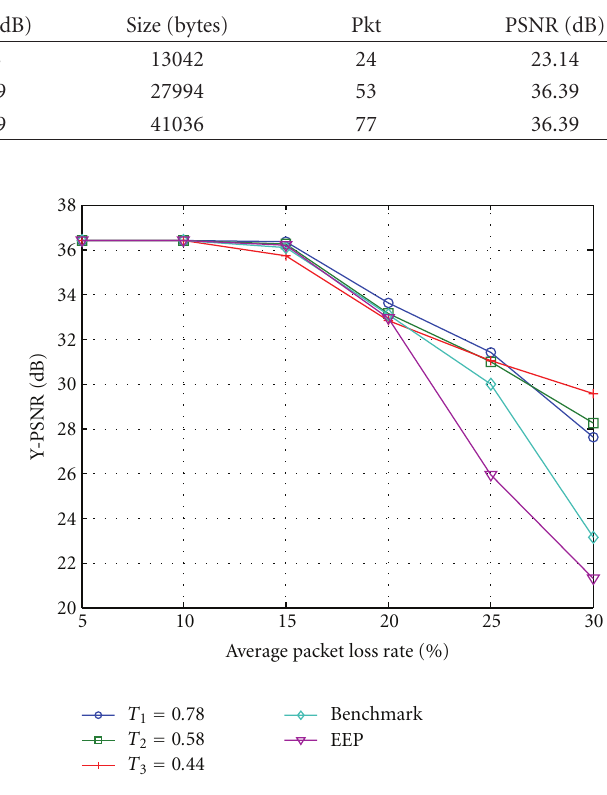
Figure 6: Optimized results for three values of T for the Foreman